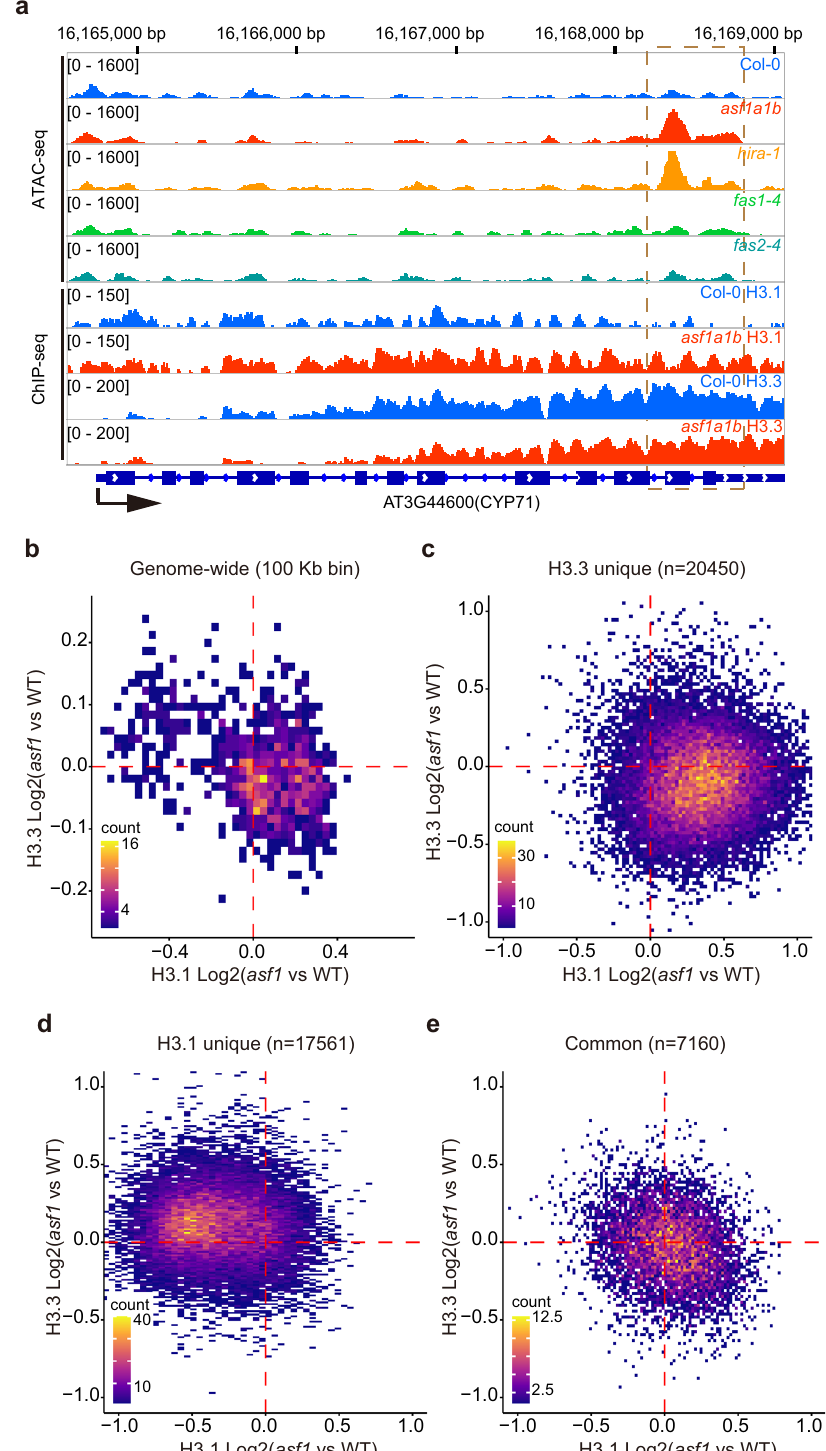
Fig.3|ASF1mutationcausesaredistributionofH3.3andH3.1.a Representative example showing H3.1 and H3.3 variation over asf1a1b and hira-1 higher accessible peak. b Scatterplot showing correlation of genome-wide H3.1 and H3.3 variationin asf1a1b ( asf1a1b vs. Col-0). The entire genome has been sliced into 100-Kb win- dows. The colored bin represents the count of dots from low (purple) to high (yellow). c Scatterplot showing correlation of H3.1 and H3.3 variation ( asf1a1b vs. Col-0)overH3.3uniquepeaks( n =20450).Thecoloredbinrepresentsthecountof